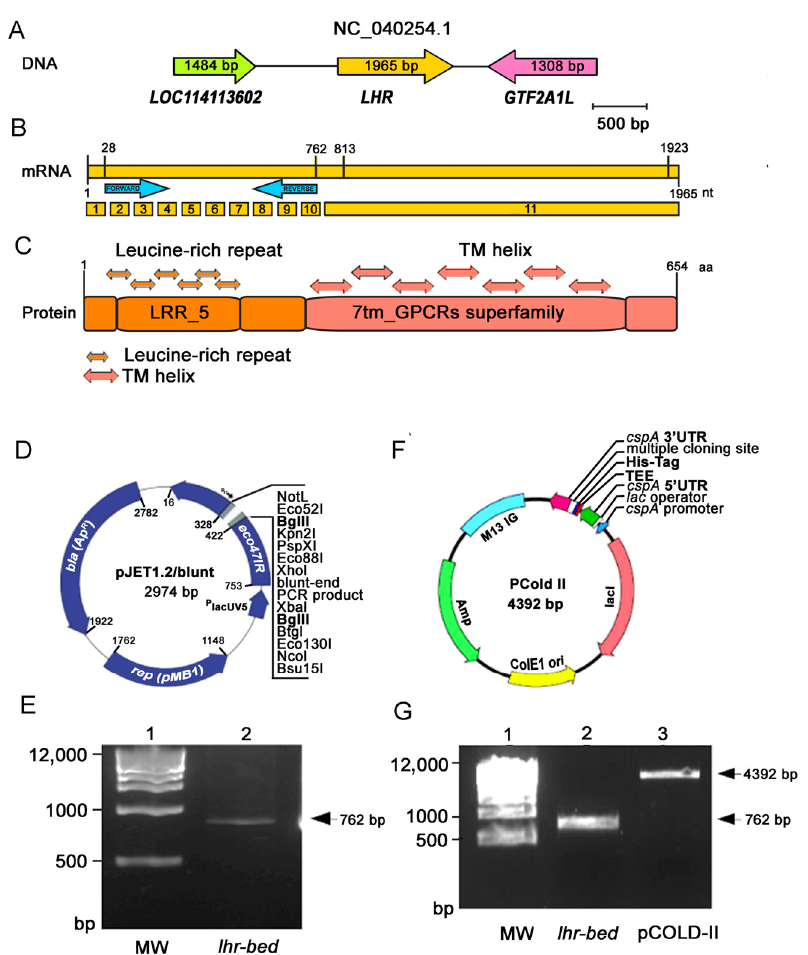
Figure 2. Genomic location of LHR gene in Ovis aries. ( A ) shows the LHR gene of 1965 bp length. Upstream and downstream of the LHR genes are the LOC114113602 and GTF2A1L gene loci encoded by 1484 bp and 1308bp, respectively. ( B ) Eleven exons encompass the LHR mRNA. Exons 1 to 10 encode the extracellular domain, while the long exon 11 encodes 7TMD and the carboxy terminal. ( C ) Arrangement of LHR predicted according to NCBI Batch CD-Search, showing 2 domains: a leucine-rich region (LRR) and seven-transmembrane helices characteristic of the GPCR superfamily. ( D ) Cloned lhr - bed gene. Characteristics of the store plasmid pJET.2/blunt cloning vector for lhr - bed are shown. ( E ) The amplicon (insert), of 762 bp, corresponding to lhr-bed (lane 2). ( F ) Map pCOLD-II expression vector. ( G ) Bands of the expressed vector pCOLD II (lane 3) and the insert of 762 bp yielding the pCOLD II- lhr-bed as product expression after digestion by NdeI and XhoI enzymes and ligation with T4 ligase (lane 2). The MW of the DNA marker (1 kb) is shown in B and C, lane 1.